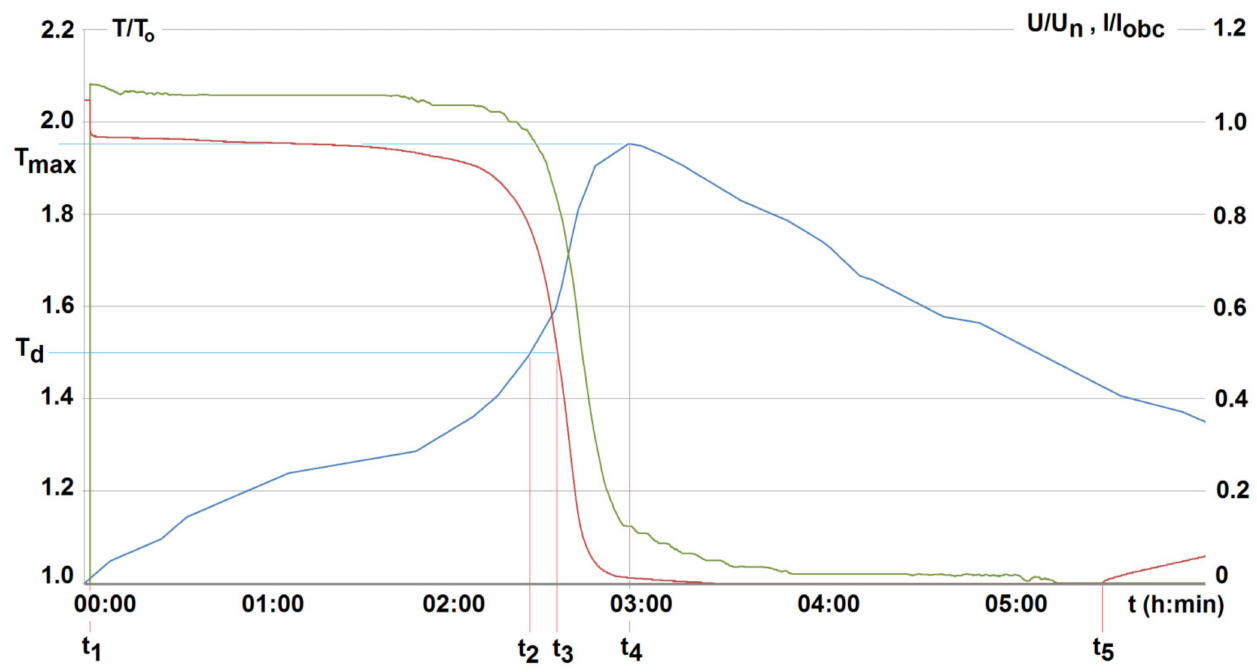
Figure 12. Variation of voltage U (red line), current I (green line ), and temperature value (blue line, T1) of a cell with time during deep discharge (to around 10% of rated voltage value U n ) for a constant load current I obc of 3.8 A; (room temperature T 0 = 22 ◦ C, free cooling; t 1 ,t 5 —moment of switching on and off the load current respectively, t 2 —temperature T d (33 ◦ C) at the minimum voltage value recorded at t 3 ; t 4 -time of maximum temperature T max (43 ◦